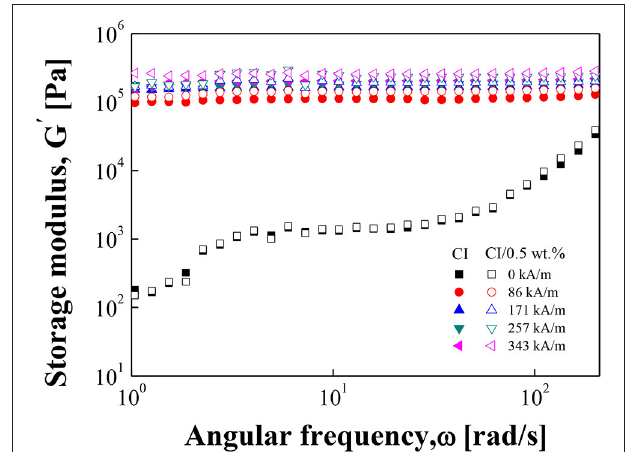
FIGURE 4 | Dynamic yield stress as a function of magnetic field strength for both pure carbonyl iron (CI)-(square symbol) and CI/BaFe 12 O 19 mixture-based magnetorheological (MR) fluids (triangle symbol).